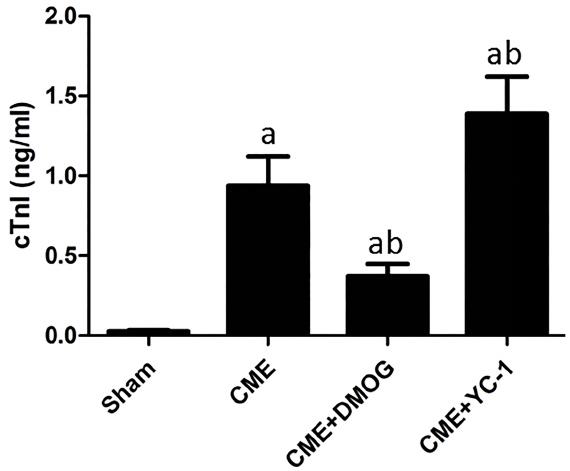
Figure 1. Parameters of cTnI in rats of each group. Serum cTnI concentrations were increased following coronary microembolization (CME). DMOG inhibited its increase despite CME, whereas YC-1 aggravates these effects. a P <0.05 in comparison to Sham group; b P <0.05 in comparison to CME group. n = 10. CME+DMOG group in comparison to CME group ( P <0.05). Infarct size of CME+YC-1 group distinctly increased in comparison to CME group ( P <0.05).